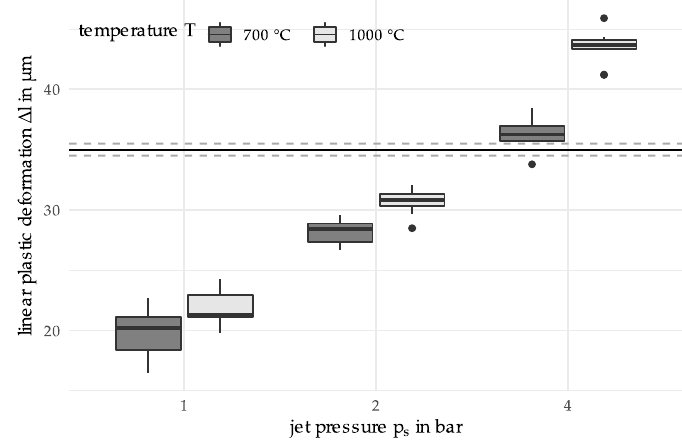
Figure 4. Boxplot for the linear plastic deformation of the initial sample data.